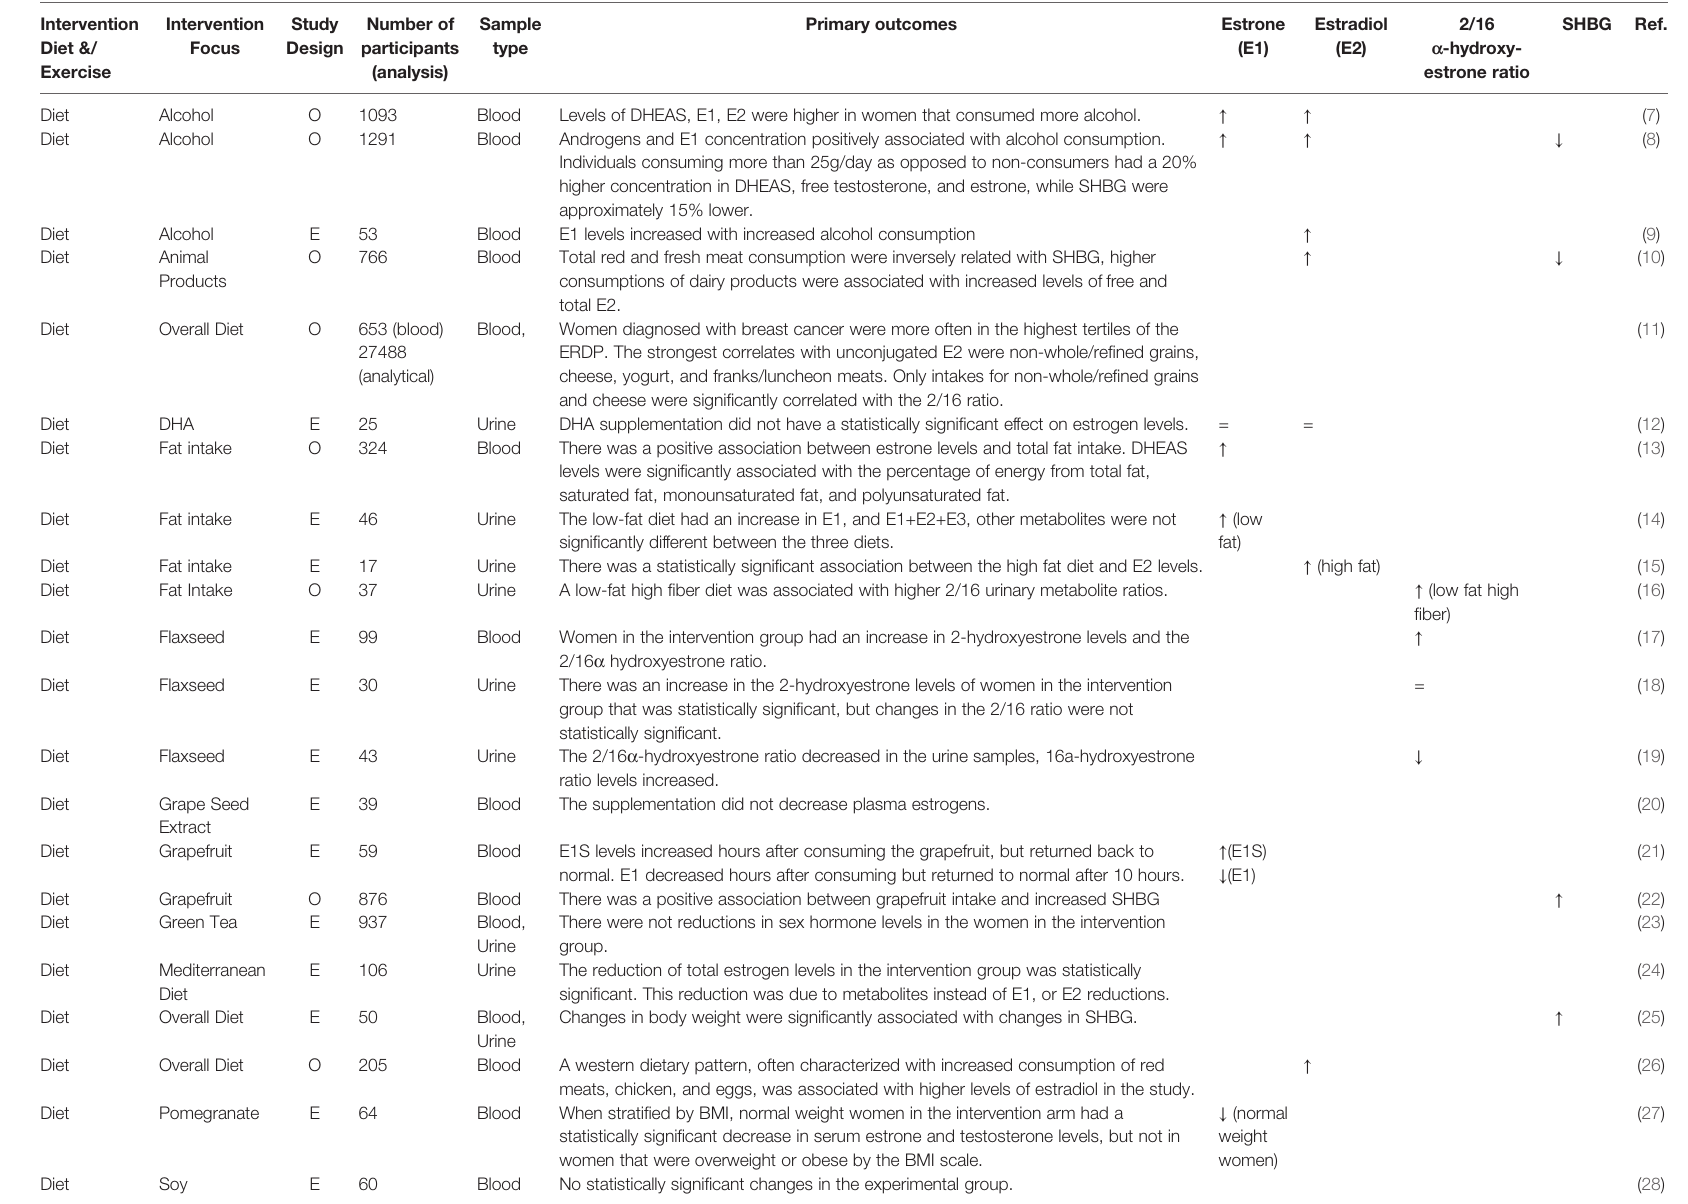
TABLE 1 | Summary of studies included for review. Intervention Diet